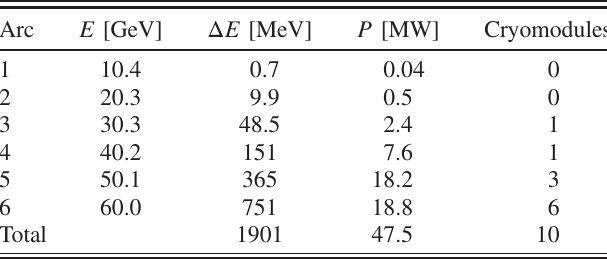
TABLE II. Energy loss, power dissipation, and the required number of compensating cryomodules for each arc.